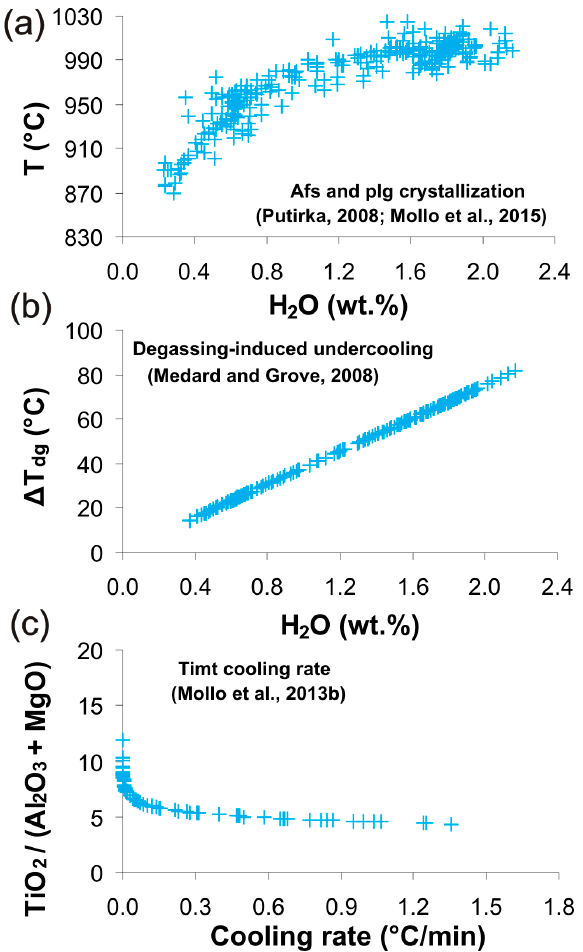
Figure 9. Temperatures ( a ) and melt-H 2 O contents ( b ) in equilibrium with plagioclase and alkali feldspar have been estimated through the two-feldspar thermometer (error ± 30 °C) of Reference [59] and thet alkali feldspar-based hygrometer (error ± 0.7 wt. % H 2 O) of Reference [20]. The degassing path and cooling rate of the sill magma ( c ) are predicted by the experimentally-derived equations of Reference [91] and Reference [37].